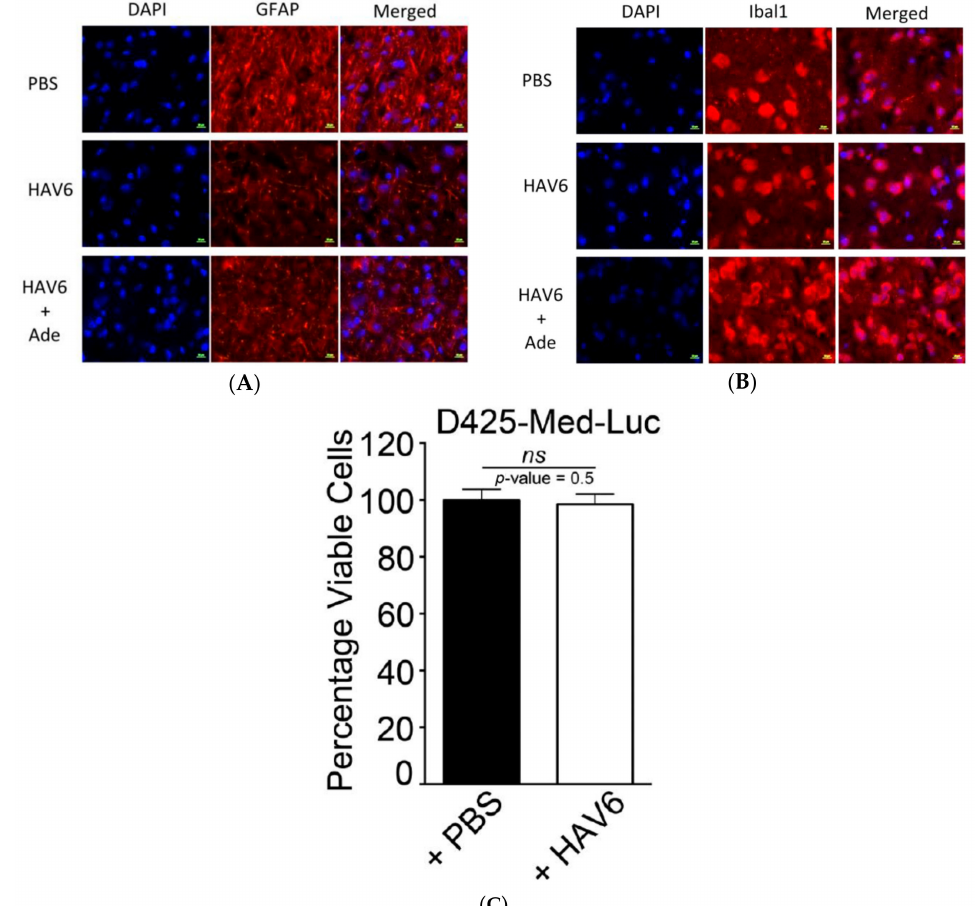
Figure 4. Representative immunofluorescence images of healthy mouse brain to detect ( A ) GFAP and ( B ) Ibal1 following the three consecutive daily treatments of PBS, HAV6 and the combination of HAV6 + Ade. The presence of HAV6 has no impact on the expression level of GFAP and Ibal1 compared to PBS control. Scale bar in bottom represent 10 µ m. ( C ) Graphical representation of viability of D425-Med-Luc cells treated with either vehicle control (black bars; PBS) or HAV6 peptide (0.01 mmol; white bars). Values represent mean ± SEM of viable cells from eight monolayers per treatment group. Data are expressed as the percent viable cells compared to D425-Med-Luc cells receiving culture media alone. HAV6 has no negative impact on cell viability; t -test indicated p -value is 0.496952 and is non-significant ( ns